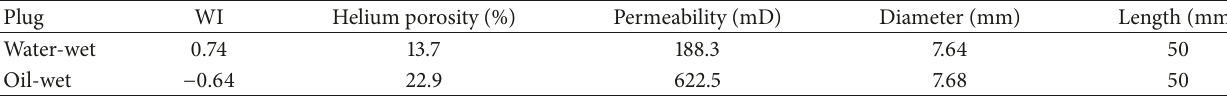
Table 1: Main petrophysical properties of the sandstone